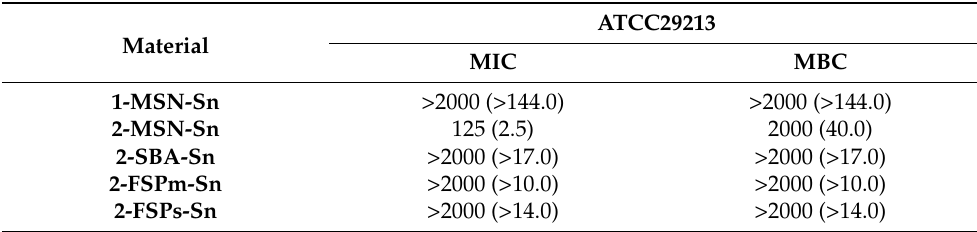
Table 5. Minimum inhibitory concentration (MIC) and bactericidal concentration (MBC) for final materials against planktonic S. aureus strain. Data are given in µ g/mL of material and data in brackets refer to µ g/mL of tin.